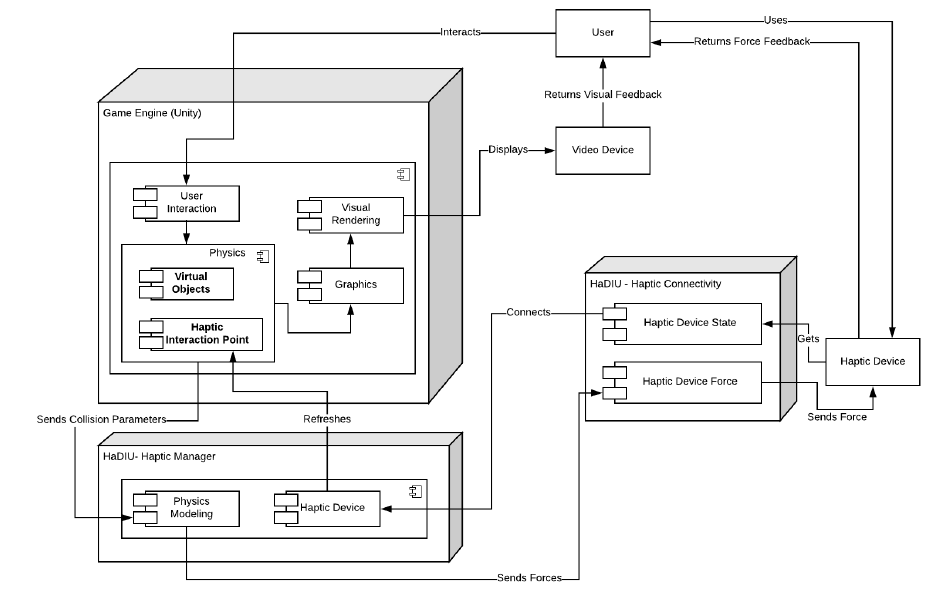
Figure 4. Deployment diagram of the proposed architecture in Unity.